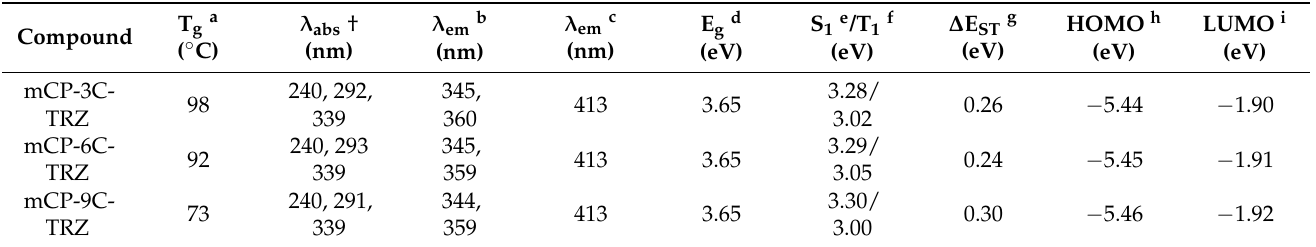
Table 1. Basic photophysical and electrochemical parameters of mCP-3C-TRZ, mCP-6C-TRZ, and